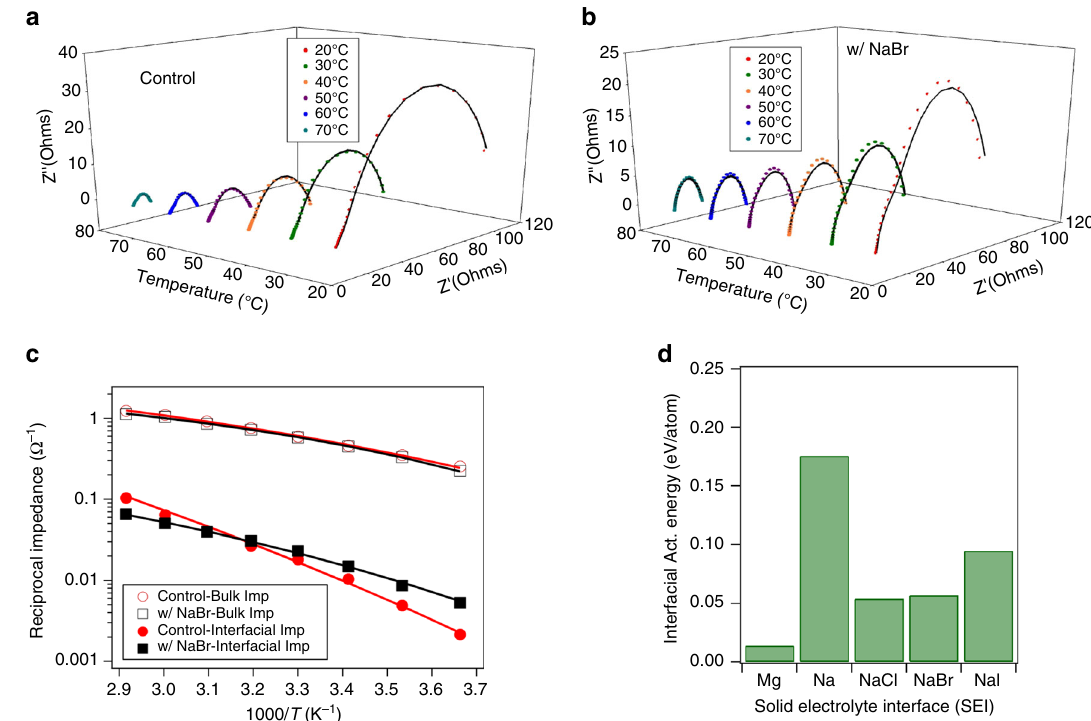
Fig. 4 Electrochemical impedance spectroscopy analysis temperature-dependent Nyquist plots for a symmetric sodium cell with ( a ) pristine sodium and ( b ) NaBr-coated sodium. c Reciprocal bulk and interface impedance as a function of reciprocal temperature; the lines are VFT model fi ts. d The apparent interfacial activation energy obtained from VFT fi ts of the temperature-dependent reciprocal resistance for various interphase chemistries. Here, Na and Mg symbolize results from symmetric cell studies with pristine sodium and magnesium electrodes, while NaCl, NaBr, NaI are for the corresponding salt-coated Na electrodes